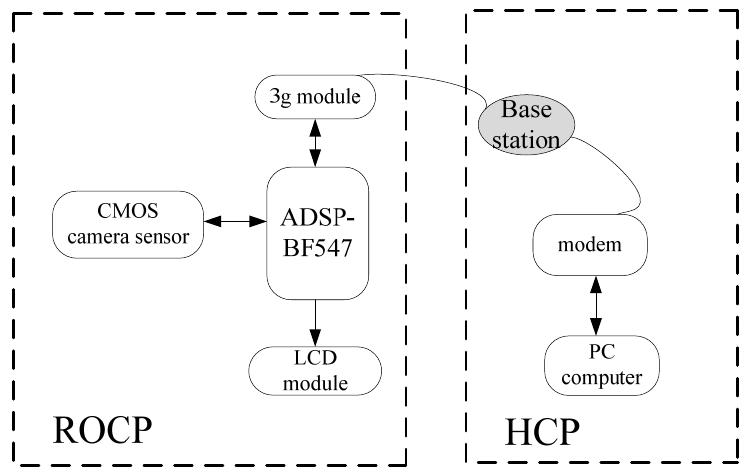
Figure 2. Architecture of the designed testing